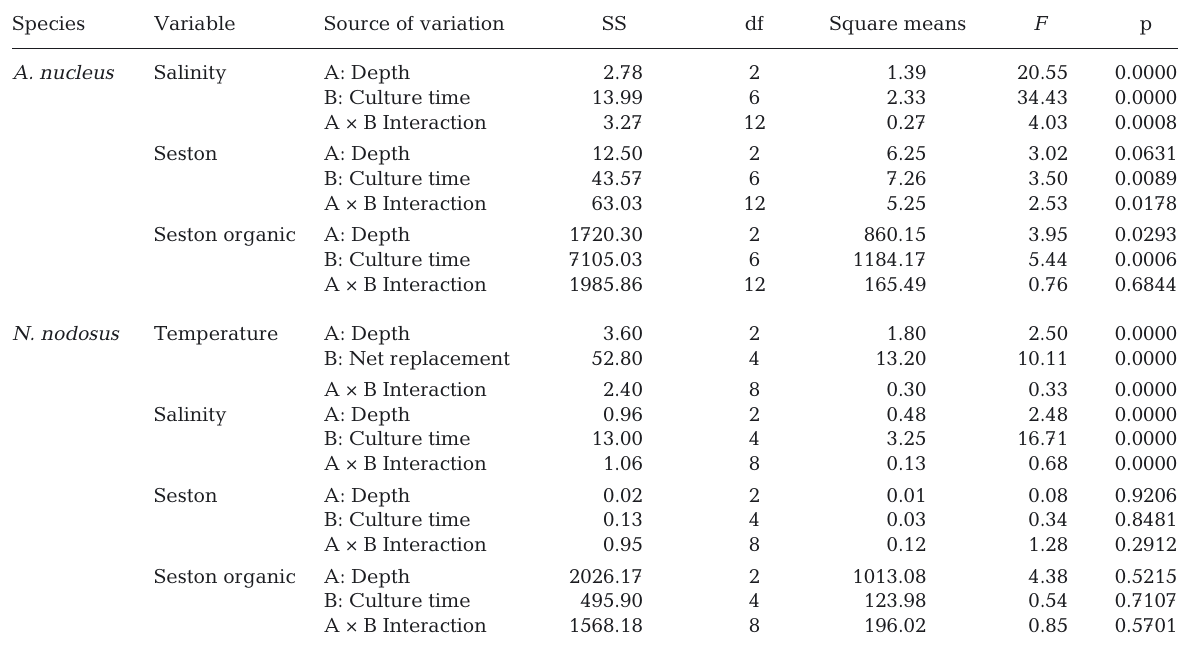
and 16 mm mo −1 . The frequency of presence of por- tunid crabs varied between 0 and 46 ind. m −2 , while their carapace widths were between 4 and 42 mm (Fig. 3B), and their growth rates were between 0 and 24 mm mo −1 . Significantly higher frequency and size of portunids were registered in April and/or June than in August (Table 1). No statistical differences